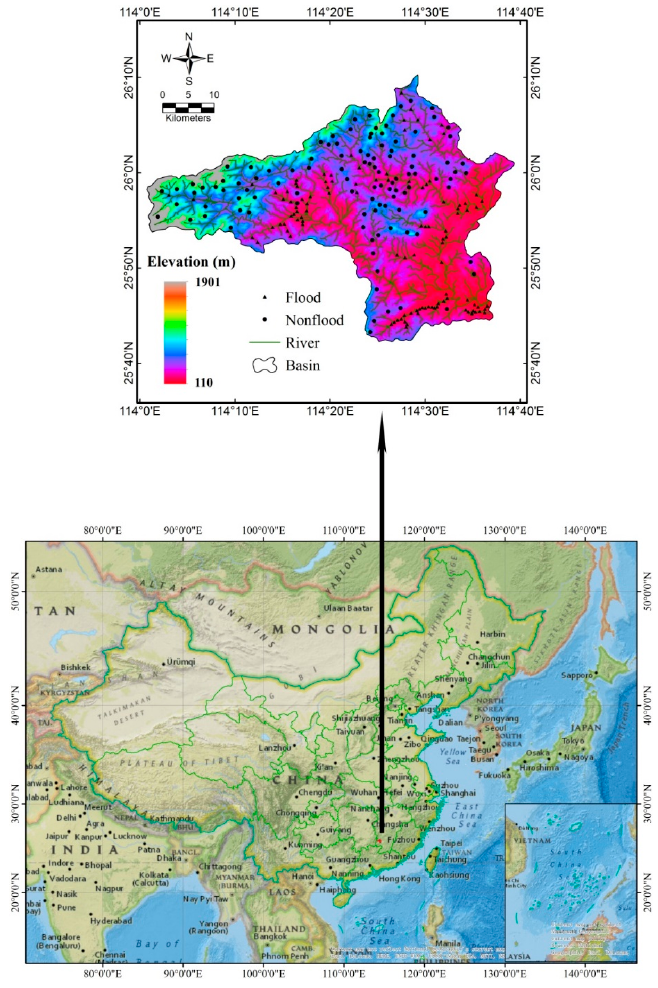
Figure 1. Flood inventory map of the study area.